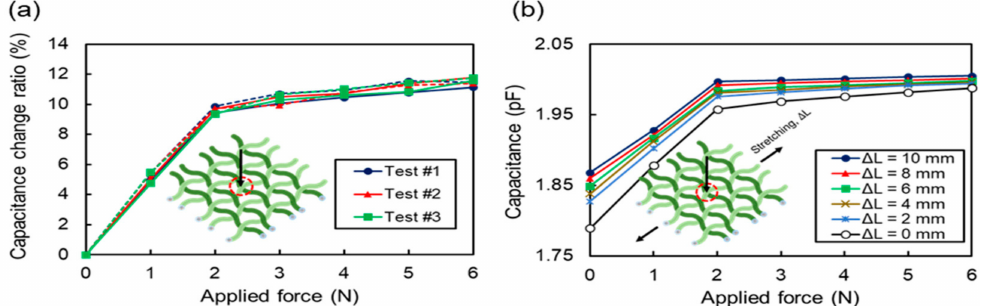
Figure 9. ( a ) Sensitivity and hysteresis response measured at a (3, 3) capacitive cell while increasing and decreasing vertical pressurizing force for three repeated applications. The measured capacitive cell was marked with a red circle in the inset. The arrow in the inset shows the direction of the applied vertical force. ( b ) Capacitance of (3, 3) capacitive cell measured at various vertical forces under various lateral stretching